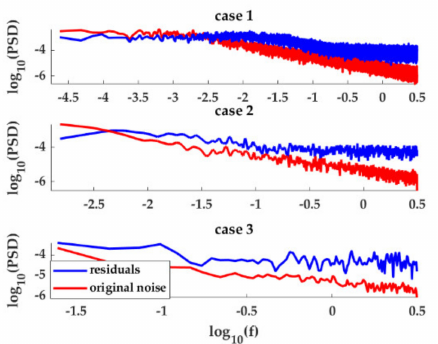
Figure 6. The PSD of the residuals for case 1 ( top ), case 2 ( middle ), and case 3 ( bottom ). The Hurst exponent for the simulated noise is H ref = 0.9. A plane was approximated with 1000 observations per line. Log–log plot. Case with additional angle